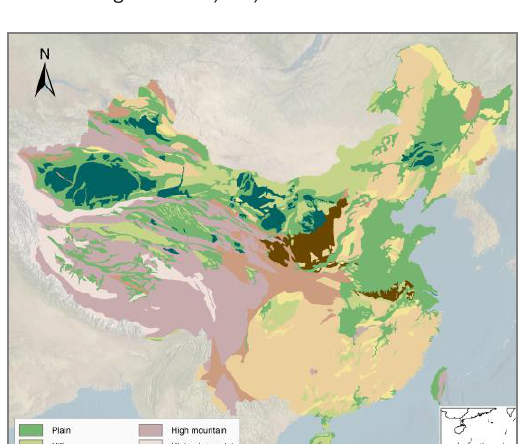
Figure 1. 1:1,000,000 DEM of China